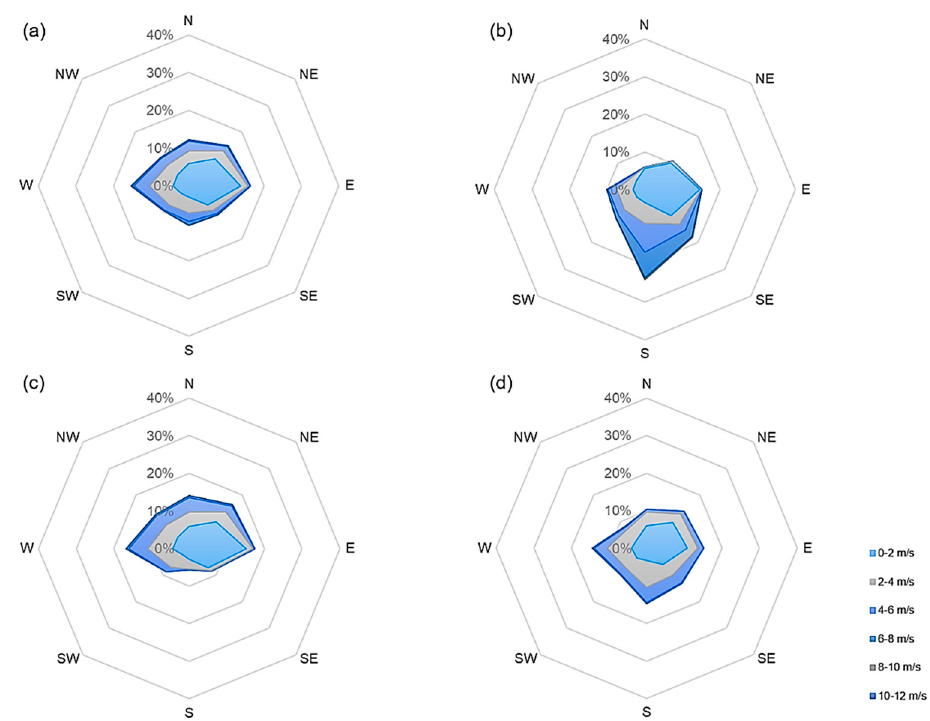
Figure A10. Wind rose from climate station during the measurement campaign in 2020 at the location Emmendingen for the periods ( a ) total: 11.03–01.05, ( b ) pre-flowering: 11.03–17.03, ( c ) main flowering: 17.03–17.04, ( d ) post-flowering: 17.04–01.05.